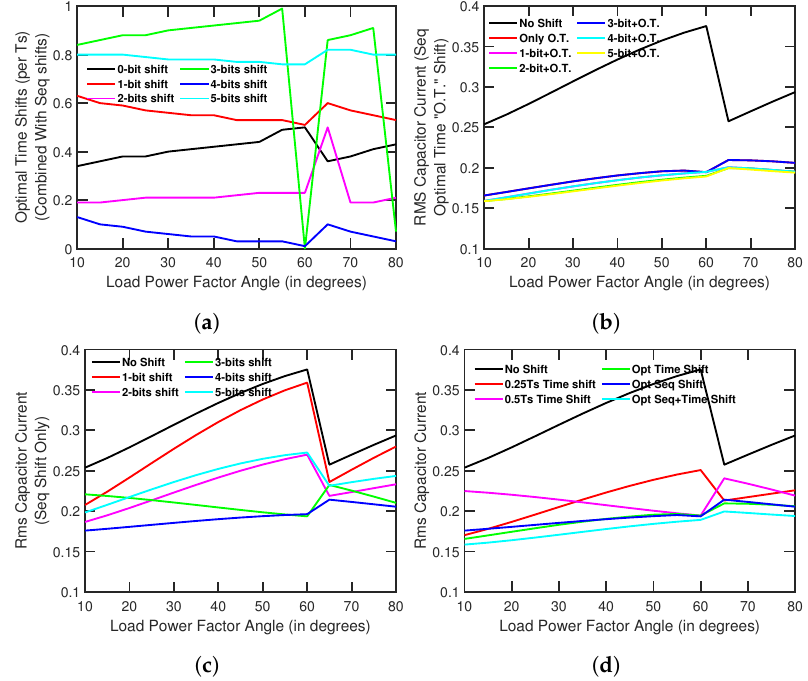
Figure 12. For equal load, a mod.index = 1 and a pf angle difference of 20 ◦ . ( a ) Optimal time shifts (combined with seq shifts). ( b ) i c,rms for seq+opt time shifts. ( c ) i c,rms for only seq shifts. ( d ) Comparative i c,rms for different interleaving shifts.